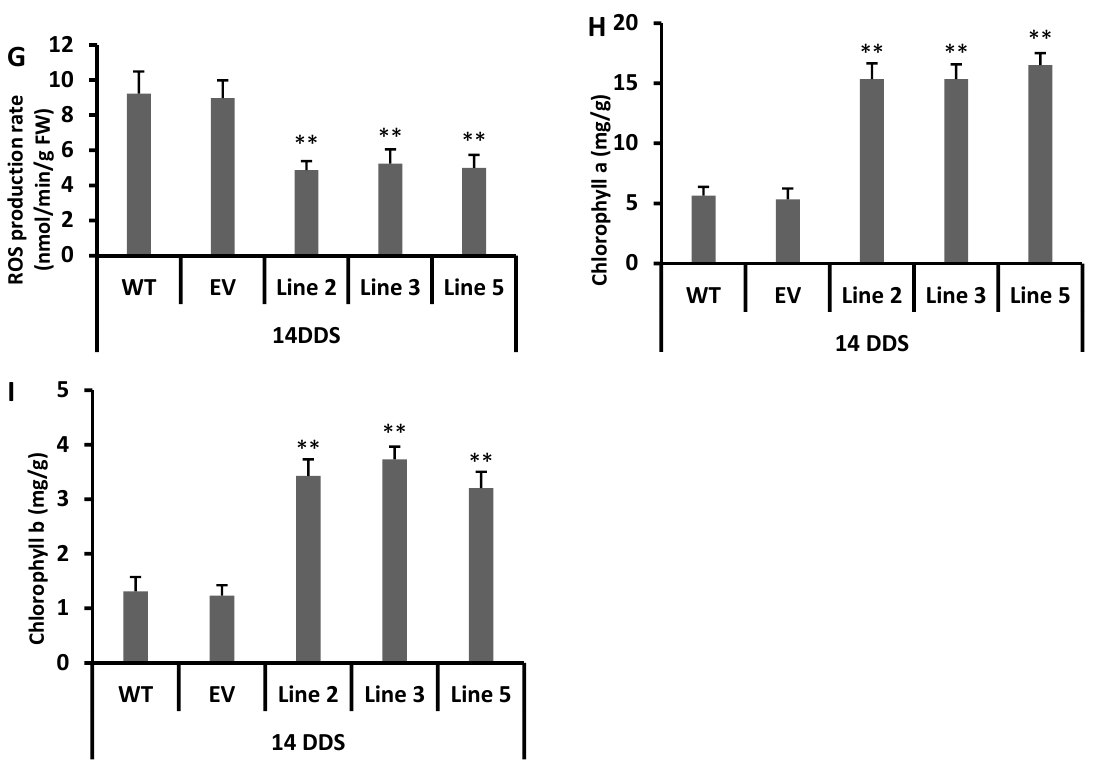
Figure 7. Drought stress effects on transgenic and wild type plants. ( A ) Trypan blue staining effect on OX and WT plants. ( B ) Nitro-blue tetrazolium (NBT) staining effect on OX and WT plants. ( C ) Hydrogen peroxide (H 2 O 2 content). ( D ) Malondialdehyde (MDA). ( E ) Electrolytic leakage (EL). ( F ) Superoxide radicals production rate (O 2 − ). ( G ) Reactive oxygen species (ROS). ( H ) Chlorophyll a ( I ) Chlorophyll